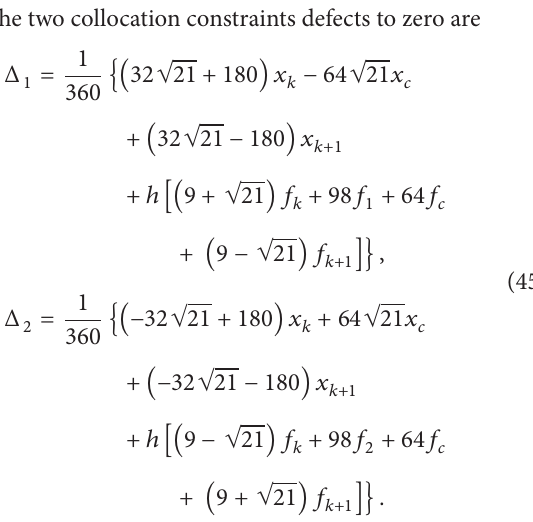
seven LGL points. Table 1 lists the corresponding position of these LGL points (the time interval is [−1, 1]